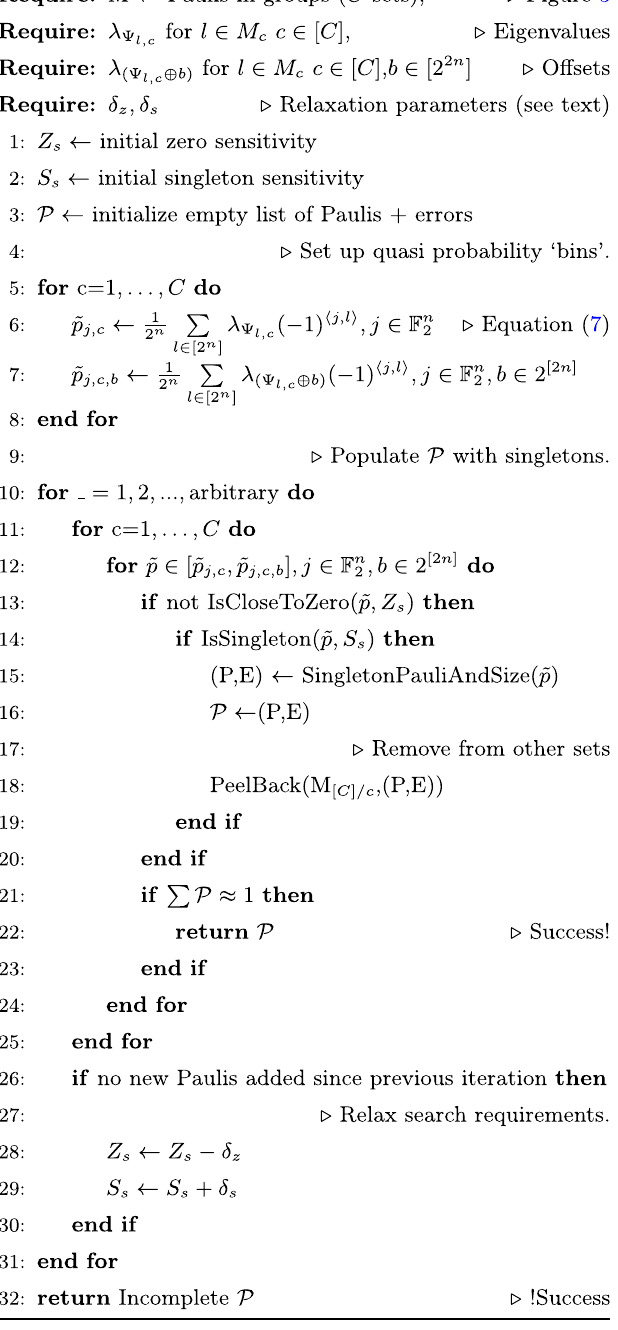
Algorithm 1. Noisy peeling